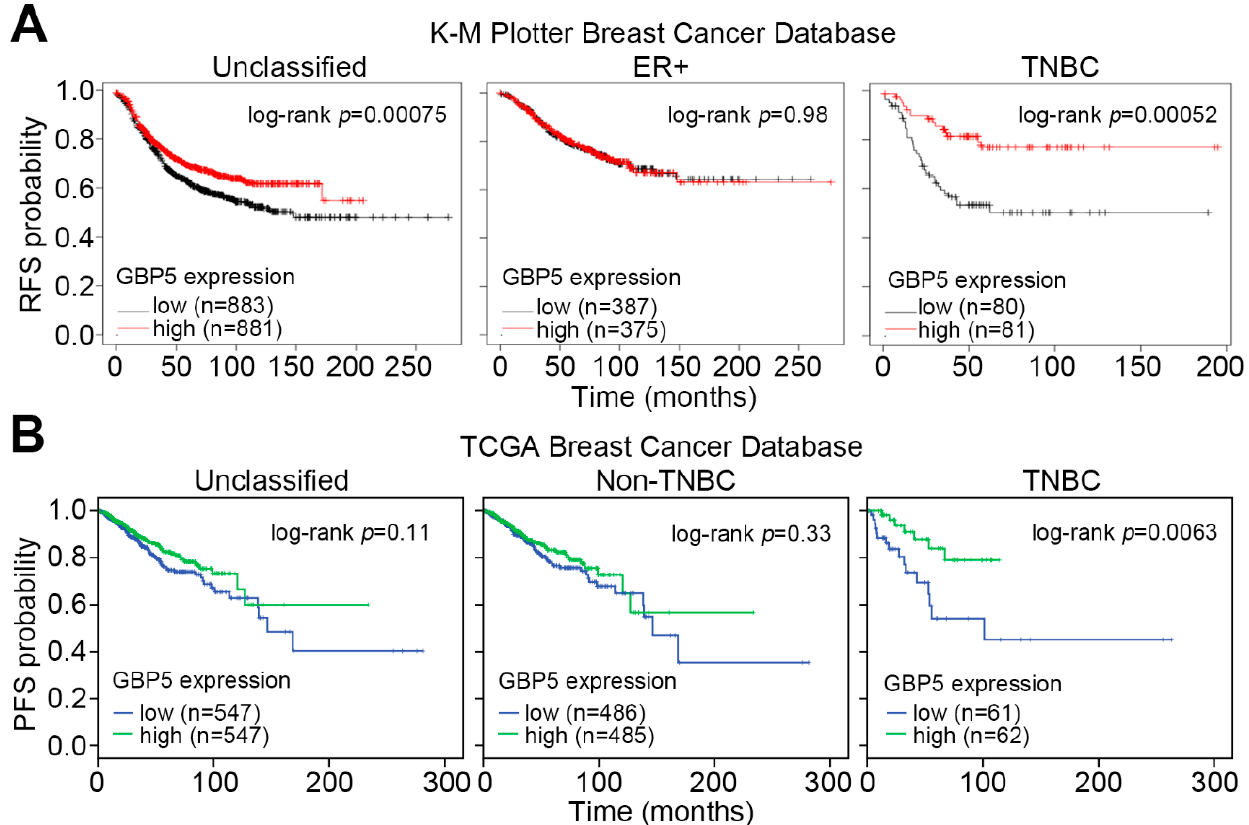
Figure 2. The prognostic significance of GBP5 is dominant for TNBC cohorts. ( A , B ) Kaplan–Meier analyses for GBP5 transcripts using recurrence-free for K–M Plotter cohort ( A ) and progression-free for TCGA cohort ( B ) survival conditions against the unclassified ( left ), ER+ or non-TNBC ( middle ), and TNBC ( right ) patients that were stratified by the media of GBP5 mRNA levels.